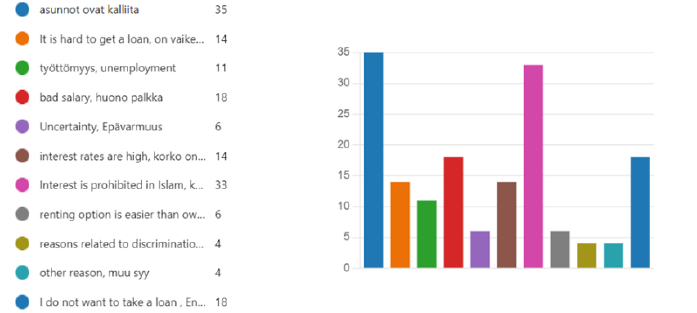
Figure 6. Reasons not to own a dwelling in Finland. Source: (Authors’